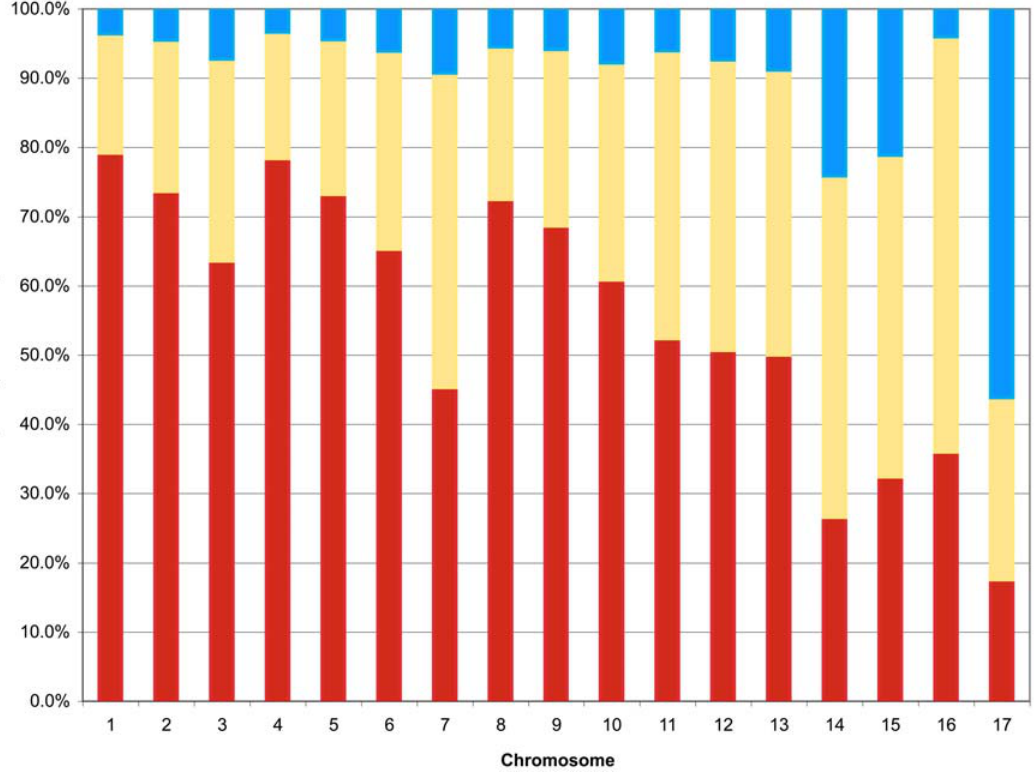
Figure 1. TBLASTN analysis of genes on each chromosome. The relative frequency of the best TBLASTN hits for proteins from each N. haematococca MPVI chromosome. The red line depicts hits to the F. graminearum genome, the yellow line depicts hits to one of the seven other fungal species, and the blue line represents hits to none of the fungal species included in the search.